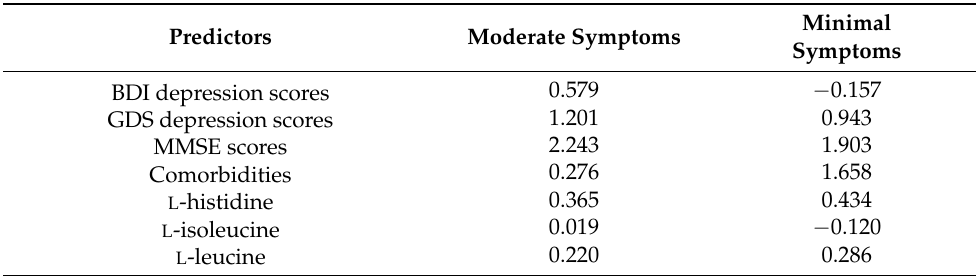
Table 4. Outcomes of classification function coefficients in moderate and minimal depressive symptom